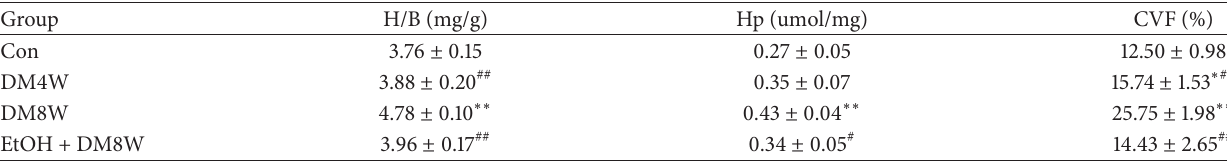
Table 2: Changes of heart weight/body weight (H/B), hydroxyproline (Hp) content, and collagen volume fraction (CVF) in different groups.